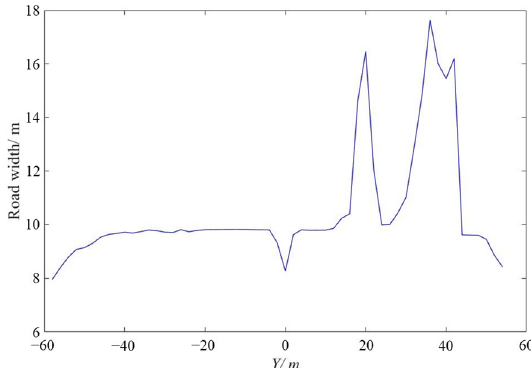
Figure 13. Road width.